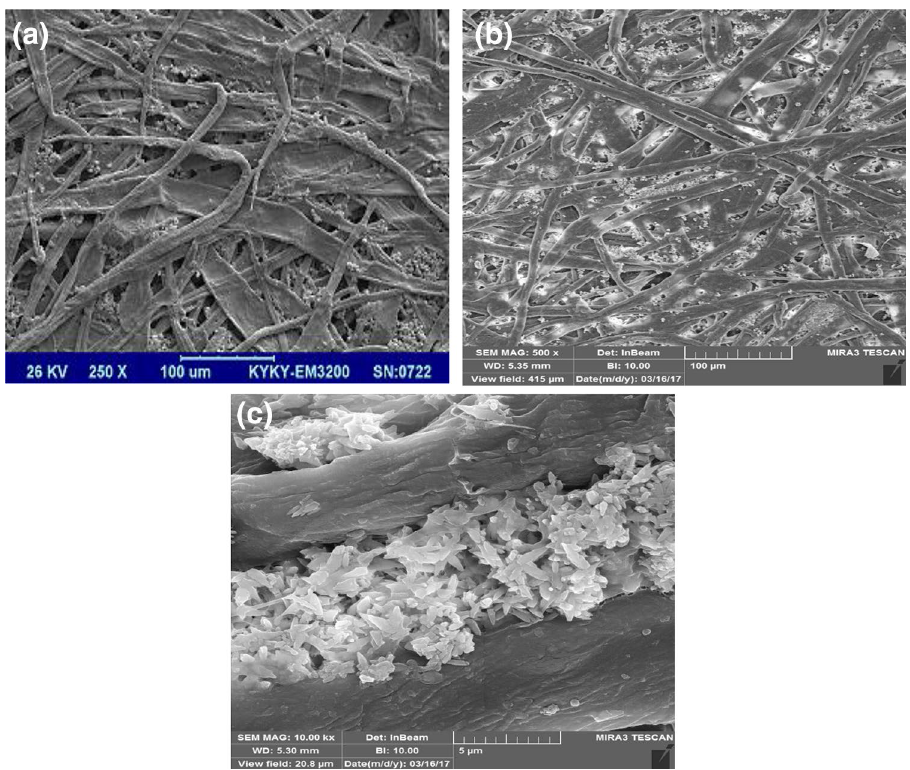
Fig. 3 SEM images of paper surface a before and b after gel electrolyte coating, c morphol- ogy of paper surface with gel electrolyte in 5 μm